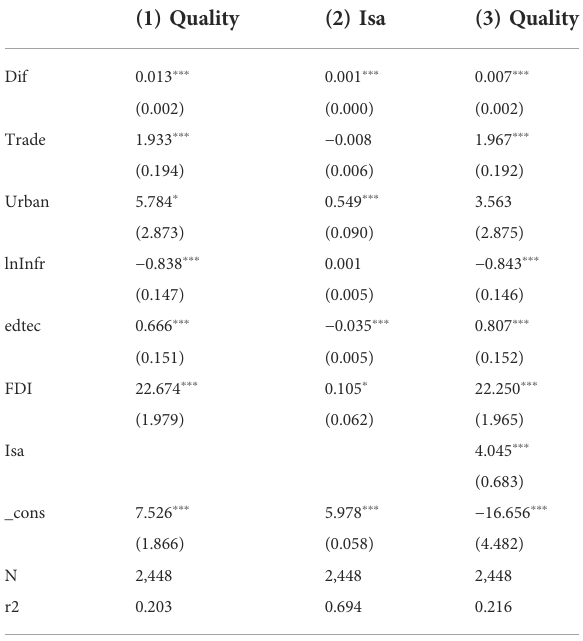
TABLE 8 Results of mediation mechanism